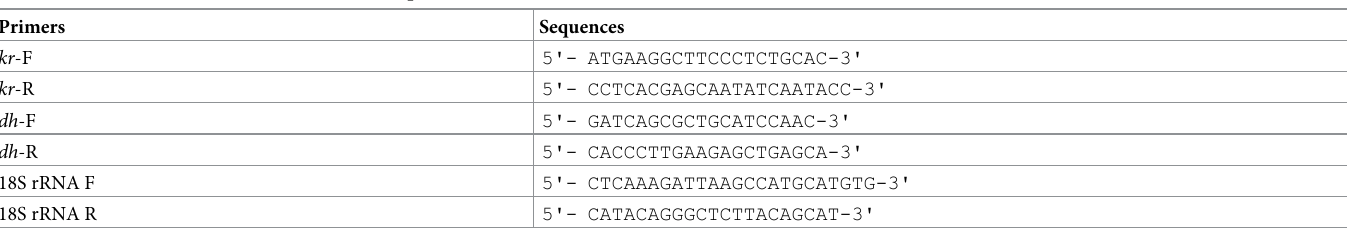
Table 2. Primers used for real-time fluorescence quantitative